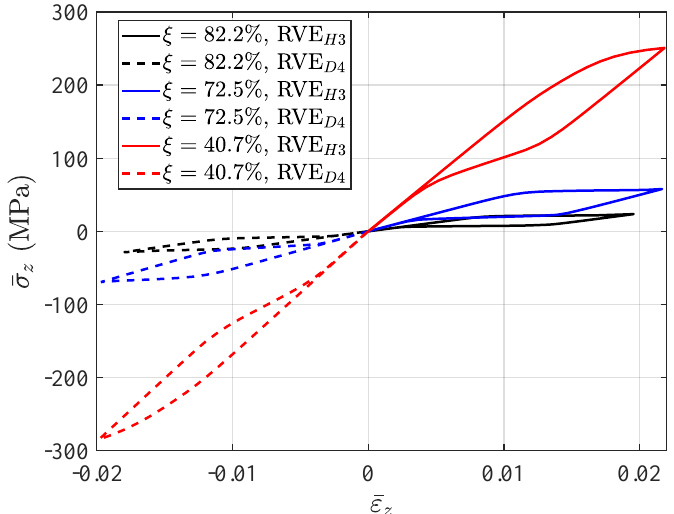
Figure 20. The comparison of the stress-strain relations on the macroscopic Integration Points H3 and D4 simulated by three kinds of RVEs